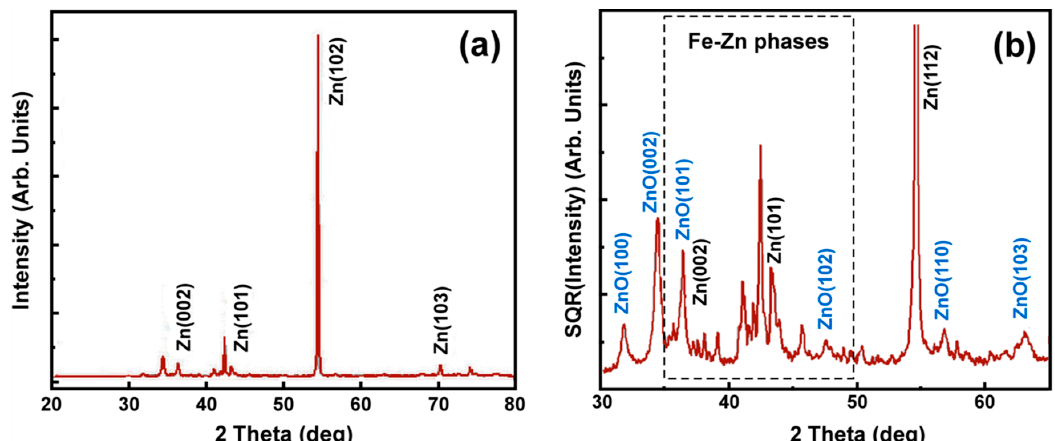
Figure 3. Bragg–Brentano (BB-XRD) diffraction pattern of the hot-dip galvanized sample with intensity on the ( a ) and the square root of the intensity ( b ) on the y -axis, respectively. Use of the square root enables identification of even the lowest intensity peaks of the XRD pattern.